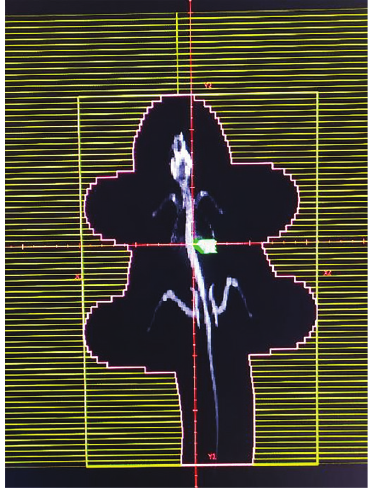
FIGURE 2 - Rat total body 3D dose plan